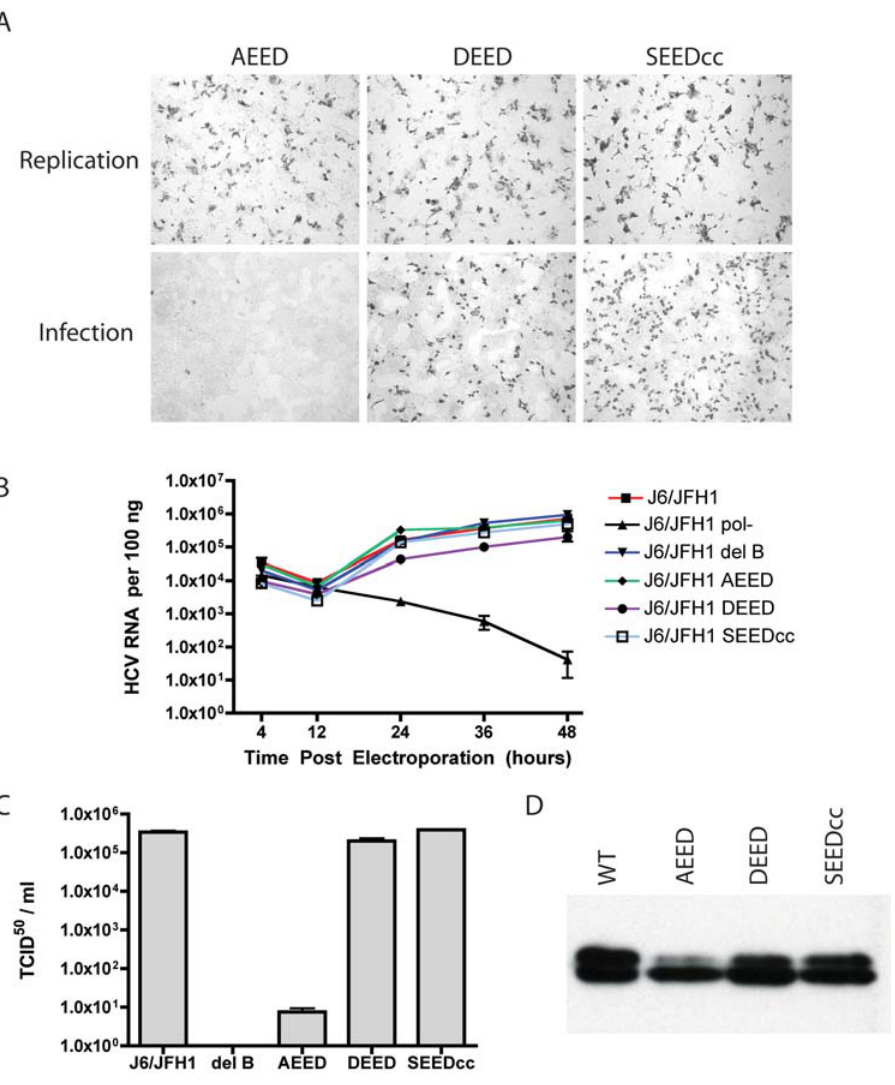
Figure 3. Single amino acid mutations that mimic phosphorylation of serine 457 alter particle assembly. A). IHC analysis of cells electroporated with indicated point mutation bearing viral RNAs. AEED indicates mutation of serine 457 to alanine, DEED is the same residue changed to aspartic acid, SEEDcc is a change of the codon of serine 457 while retaining serine at this position. Rows of images are as described in 1B, 2B and 2D. B). RNA replication 48 hour time course of J6/JFH-1 (red line), J6/JFH-1 deletion B (blue line), J6/JFH-1 pol- (black line), AEED RNA (green line), DEED RNA (purple line), and SEEDcc RNA (light blue line) as determined by real time PCR analysis. C). Infectivity release 48 hours post electroporation from indicated viral RNA electroporated cells in units of tissue culture infectious dose 50% value per milliliter. D). Western blot analysis of NS5A from cells electroporated with replication competent full-length viral genomes as shown in panel A. Nomenclature used is as described in